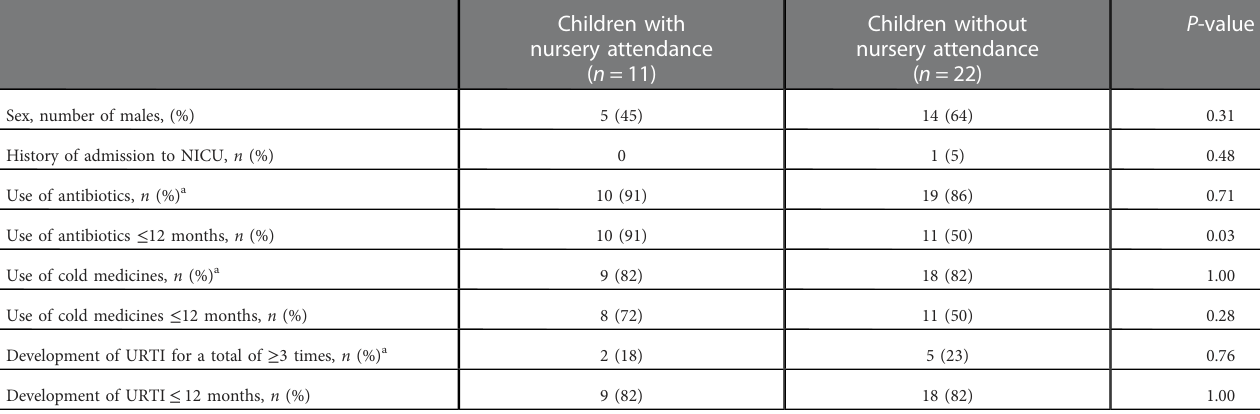
TABLE 2 Comparisons of the demographic and clinical characteristics between children with and without nursery attendance.